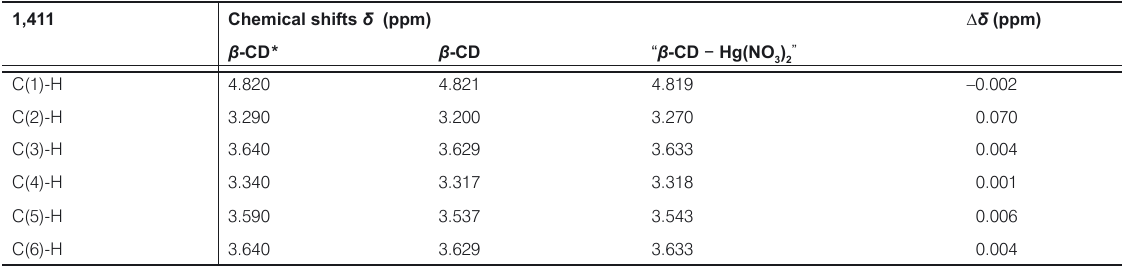
Table 5. Chemical shifts in the 1 H NMR spectra for β -cyclodextrin and its inclusion complex with mercury(II)